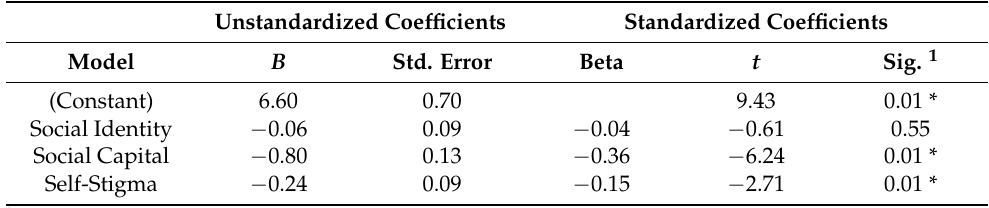
Table 2. Analysis of multiple regression results of independent variables on help-seeking for suicidal